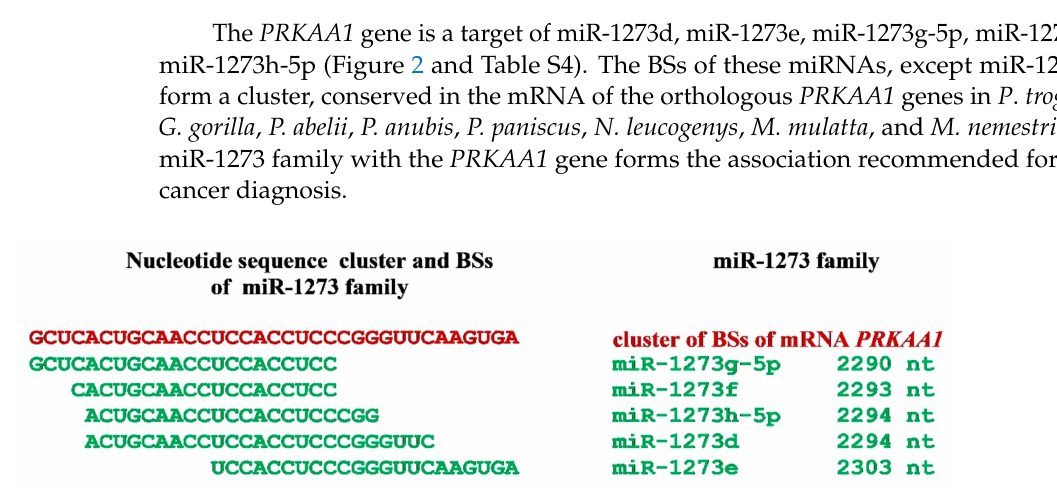
Figure 2. The scheme of miR-1273 family binding sites (BSs) in the 3 (cid:48) UTR of the mRNA of the candidate PRKAA1